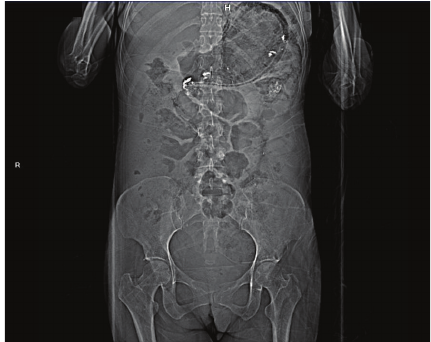
Figure 3: Abdominal scout image from a computed tomography.